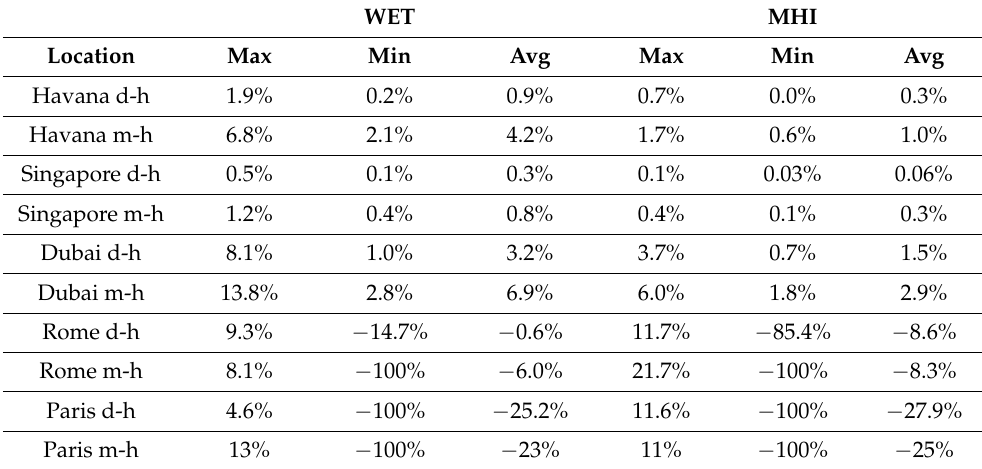
Table 2. Percentage error: maximum, minimum, average